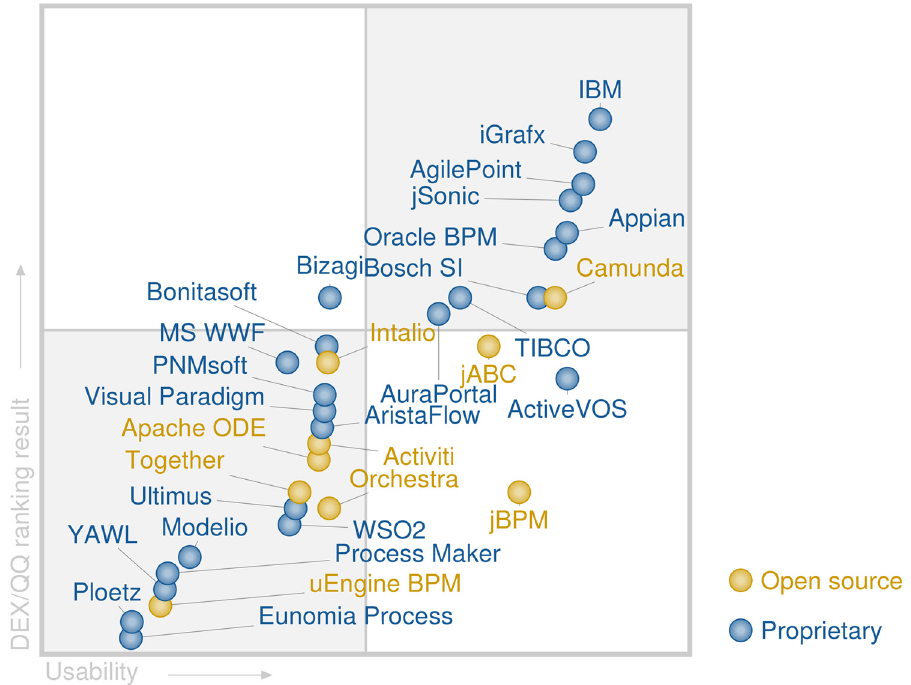
Fig 4. Magic quadrant for BPSS using the proposed hierarchical decision